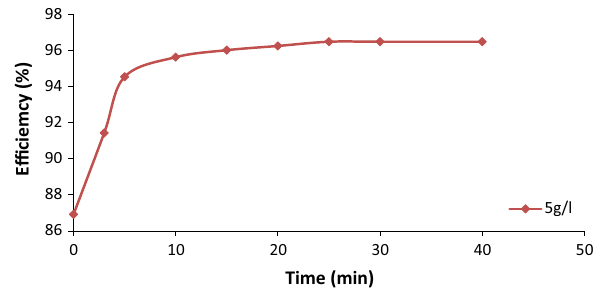
Fig. 8 The plot of settling time at 5 g/L coagulant dosage, pH 8